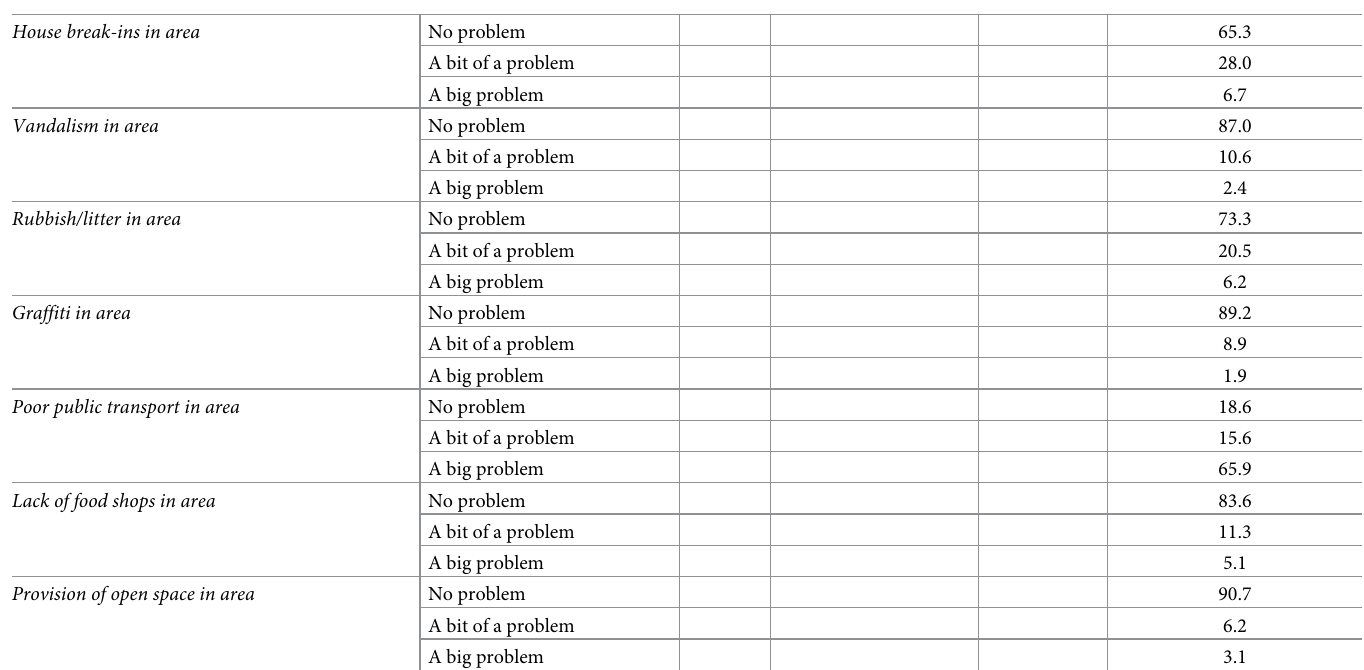
Table in S1 File. In terms of the investigation of differential interaction effects of area-level deprivation with gender and urban areas, few differential associations with mental health indi- cators were uncovered (results available on request from